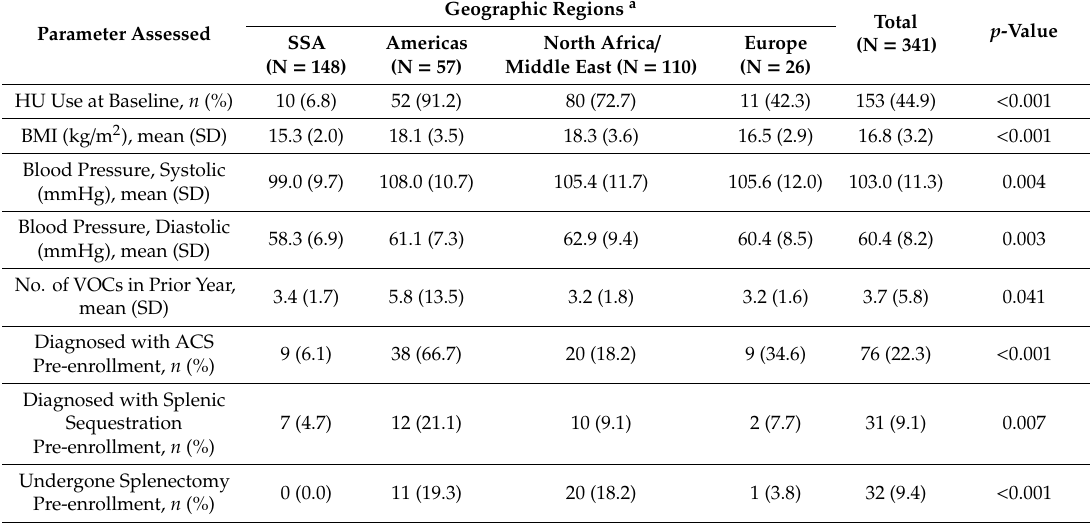
Table 2. Key baseline characteristics that significantly di ff ered among the geographic